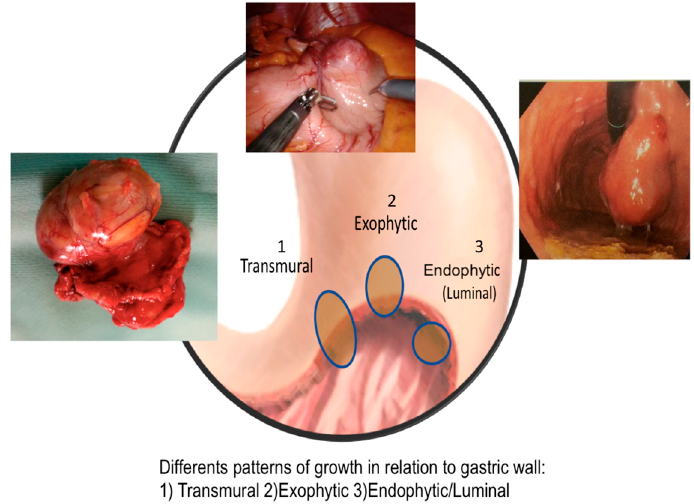
Figure 2. Different pattern of GIST growth.